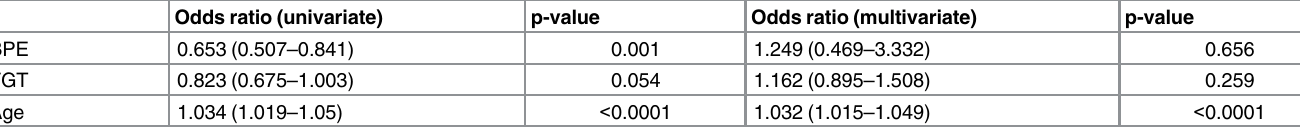
Table 2. Odds ratios for the investigated covariates regarding presence of breast